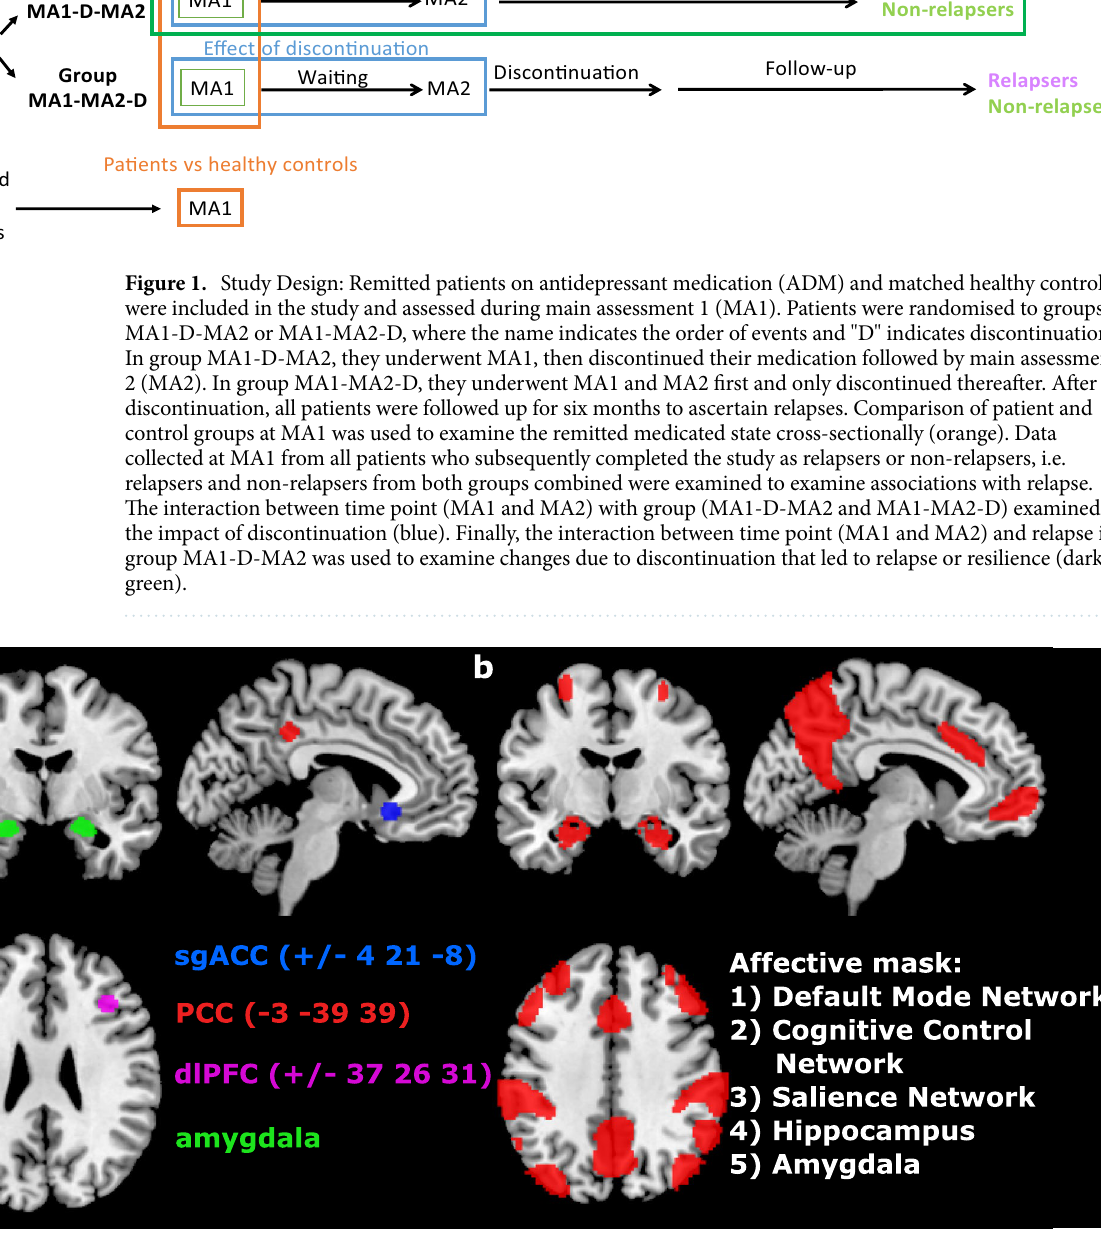
Figure 2. Seeds and Mask: Depicted are the seeds ( a ) used in the analysis and the affective mask ( b ) containing all voxels of interest. sgACC subgenual anterior cingulate cortex, PCC posterior cingulate cortex, dlPFC dorsolateral prefrontal